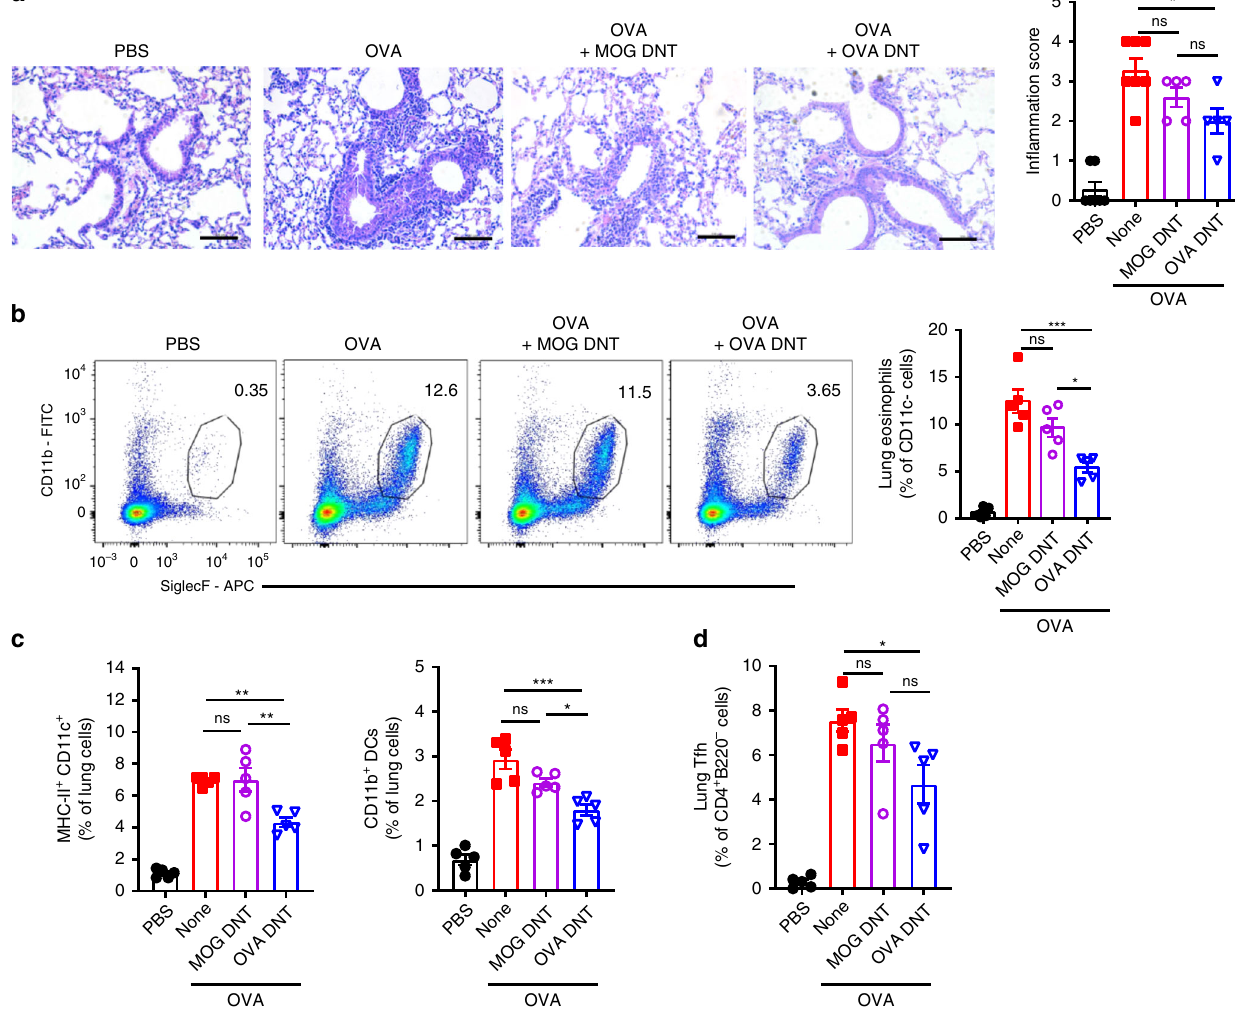
Fig. 5 OVA DNTs speci fi cally protected mice against OVA-induced airway in fl ammation. Mice received MOG DNTs or OVA DNTs by intravenous adoptive transfer to treat OVA-induced airway in fl ammation. a Lung sections were stained with H&E to measure the accumulation of in fi ltrating in fl ammatory cells. (Scale bars, 100 μ m). b Eosinophils (Siglec F + CD11b + CD11c − ) in the lung were assessed by fl ow cytometry. c Lung DCs (CD11b + CD11c + MHC-II + ) and d Tfh cells (CD4 + B220 - CXCR5 + PD-1 + ) were assessed by fl ow cytometry. The results are representative of two experiments with similar results. Data are shown as the mean ± SEM; n = 5 mice per group. One-way ANOVA was used to calculate signi fi cance. * P < 0.05; ** P < 0.01; *** P < 0.001. Source data are provided as a source data fi